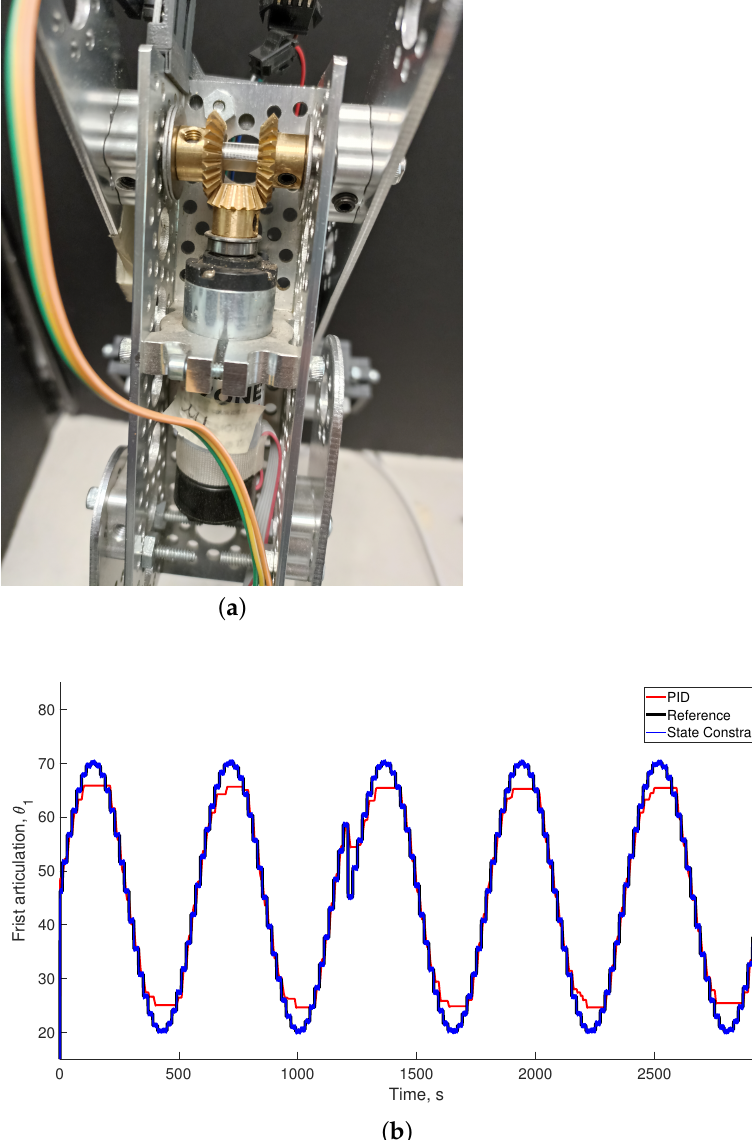
Figure 4. ( a ) Photograph of the electromechanical configuration for the first articulation θ 1 ; ( b ) comparison of the controlled motion for the first articulation ( θ 1 ) when the PID and adaptive control with state constraints are